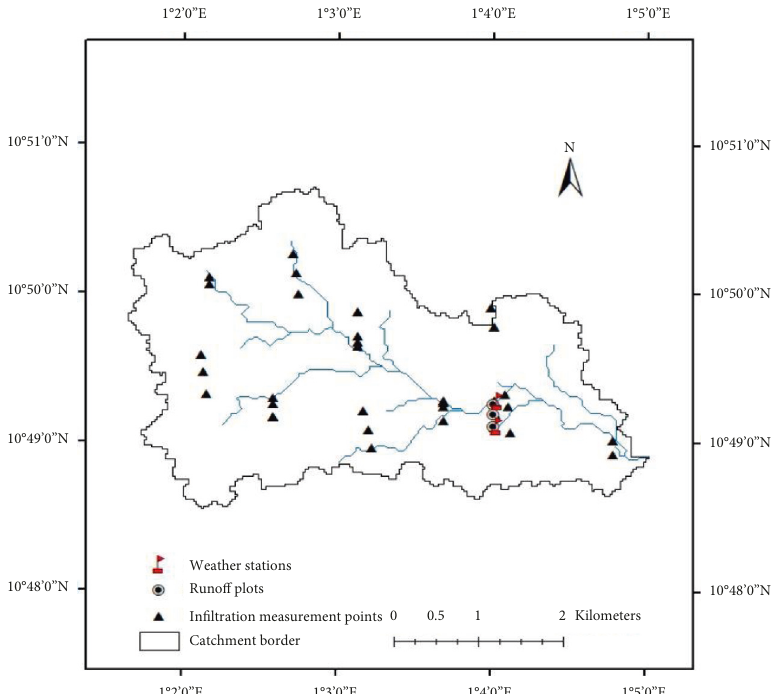
Figure 2: Infiltration measurement points in the watershed (each point represents both cropland and fallow land).